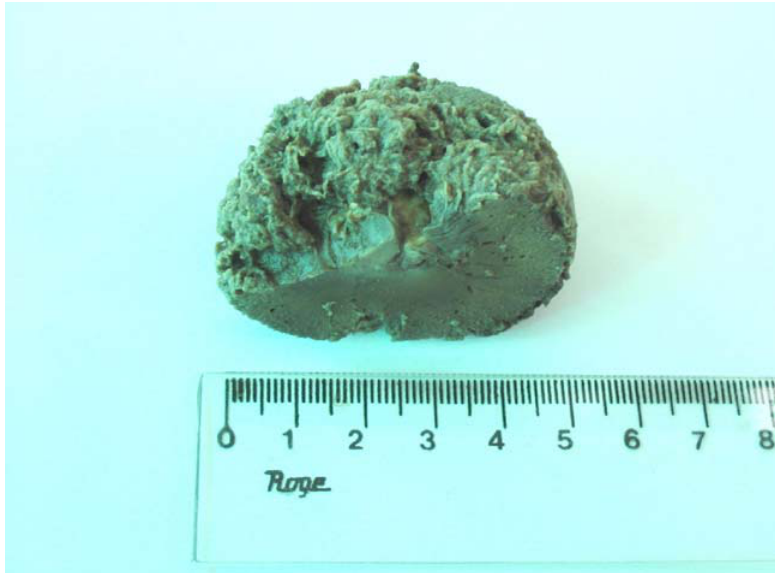
Figure 1. Advanced autolysis of the kidney - “Pulpy kidney” (tissue in formol) .